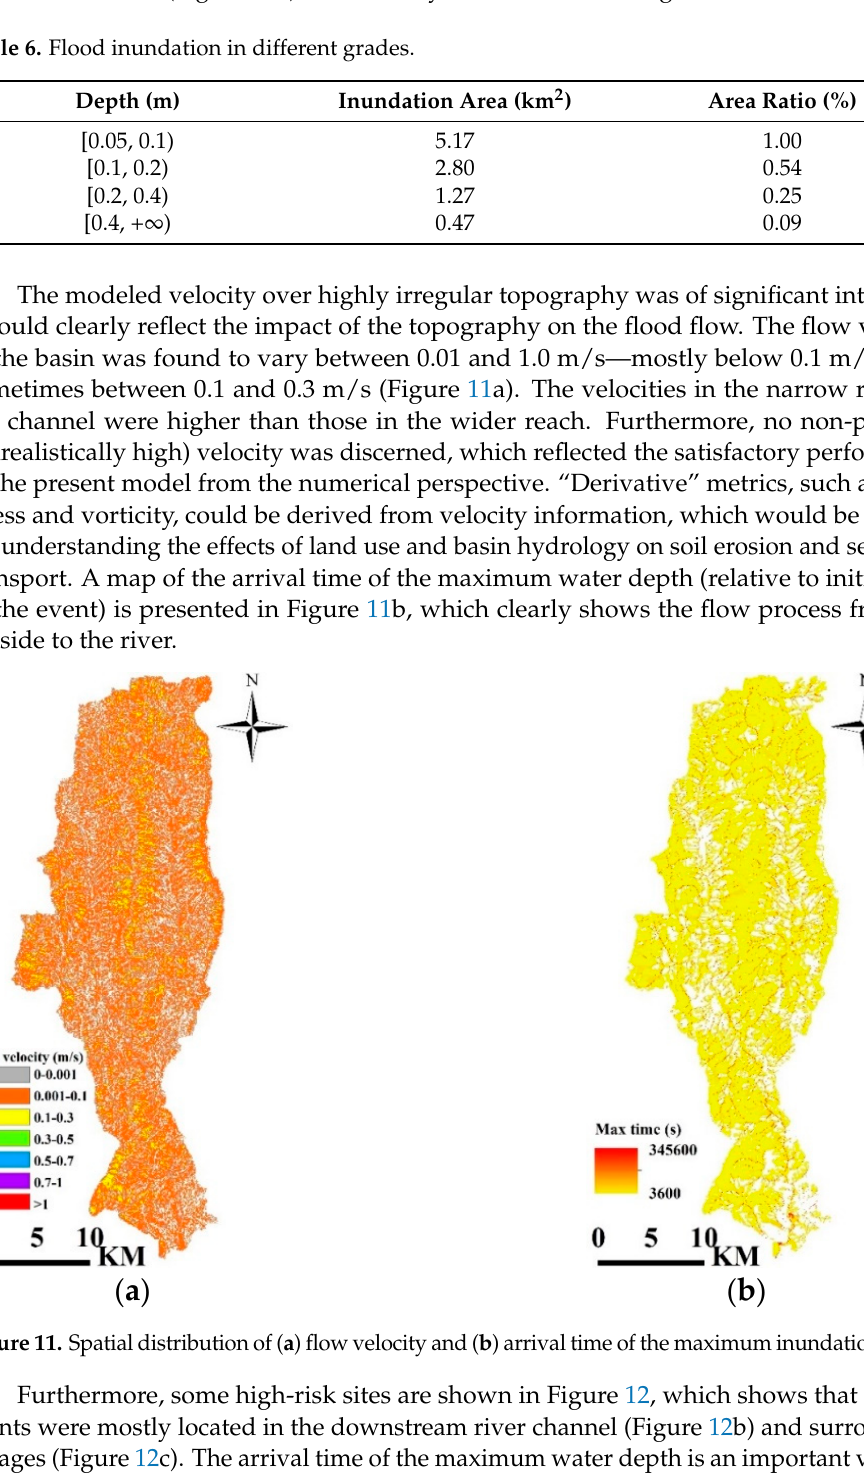
Table 6. Flood inundation in different grades.